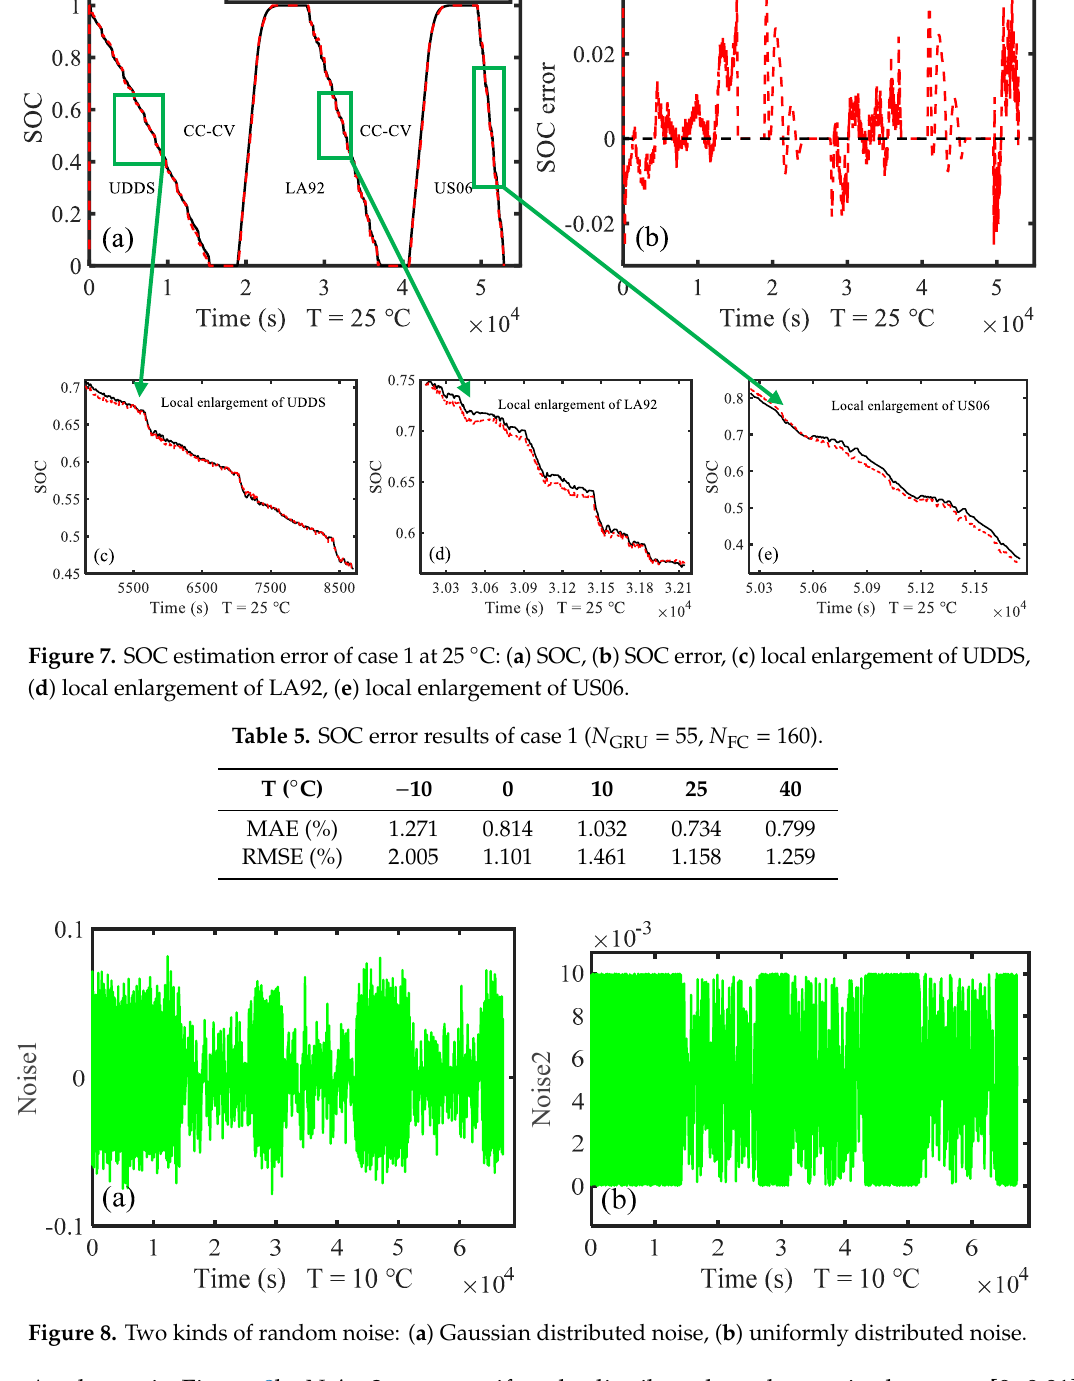
Figure 7. SOC estimation error of case 1 at 25 °C: ( a ) SOC, ( b ) SOC error, ( c ) local enlargement of UDDS, ( d ) local enlargement of LA92, ( e ) local enlargement of US06.